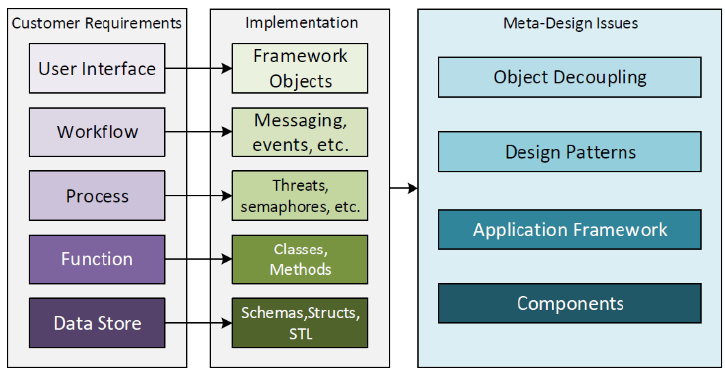
Figure 5. Global unit test